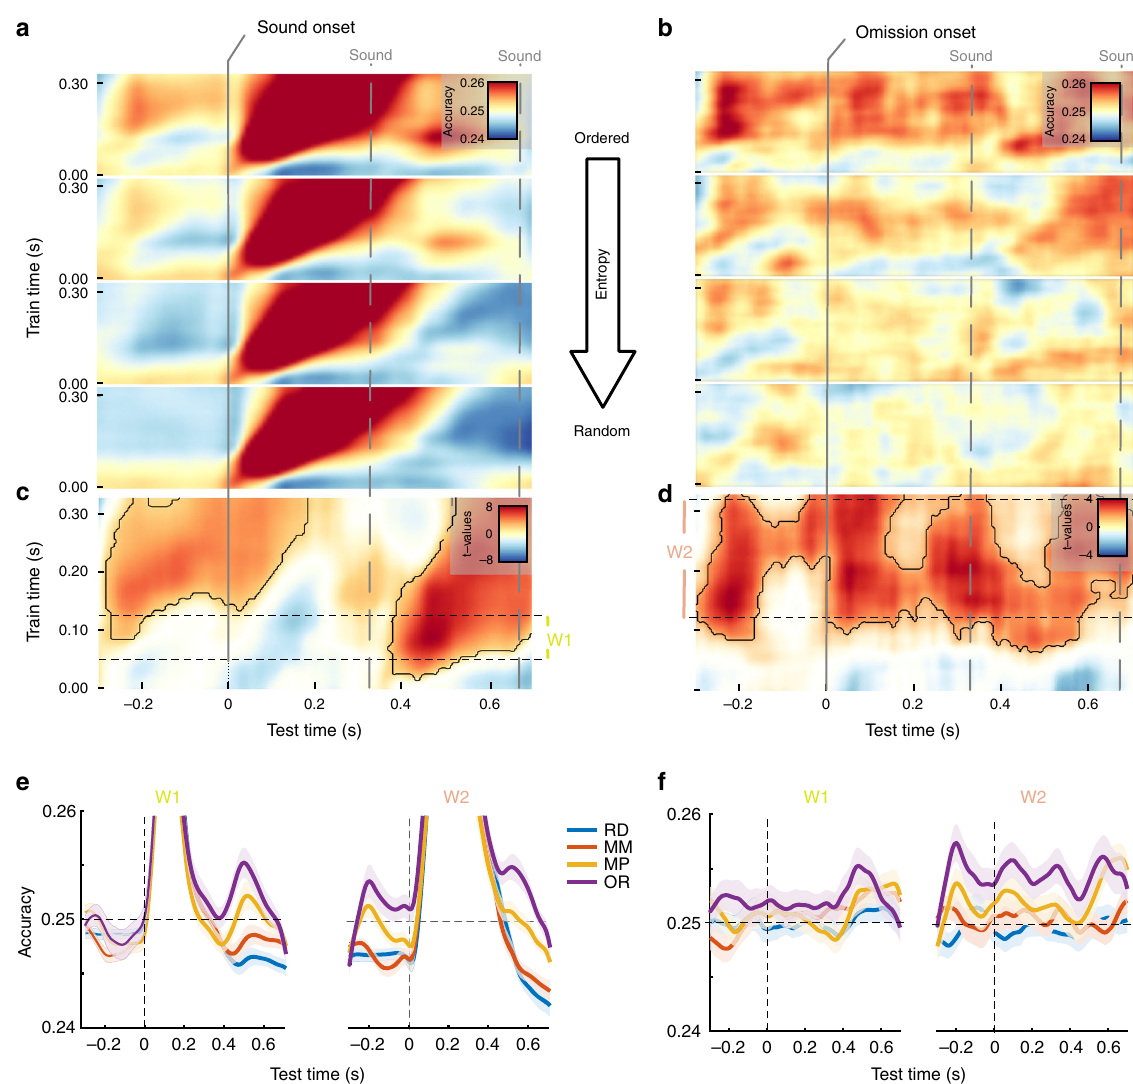
Fig. 3 Analysis for pre- and post-stimulus decoding using time-generalization of classi fi er trained on random sound sequences. a , b “ Raw ” decoding time- generalization maps (grand average across subjects), tested on sound- ( a ) and omission- ( b ) locked trials, in increasing entropy from top to bottom. c , d Regression results (sound left, omission right), using entropy level as the independent variable; red colors indicate increased decoding accuracy for more regular sequences. t -values are thresholded at uncorrected p < 0.05. The areas framed in black are clusters signi fi cant at p cluster < 0.05. e , f Decoding accuracy for individual conditions averaged for training times between the dashed lines, testing on sound (left) and omission (right). c Display of effects pre- and post-sound, showing a clear anticipation effect and a late effect commencing after ~400ms. The latter effect is more clearly visualized in ( e ). Interestingly, different train times appear to dominate the anticipation and post-stimulus effects. d Display of effects pre- and post-omission, showing